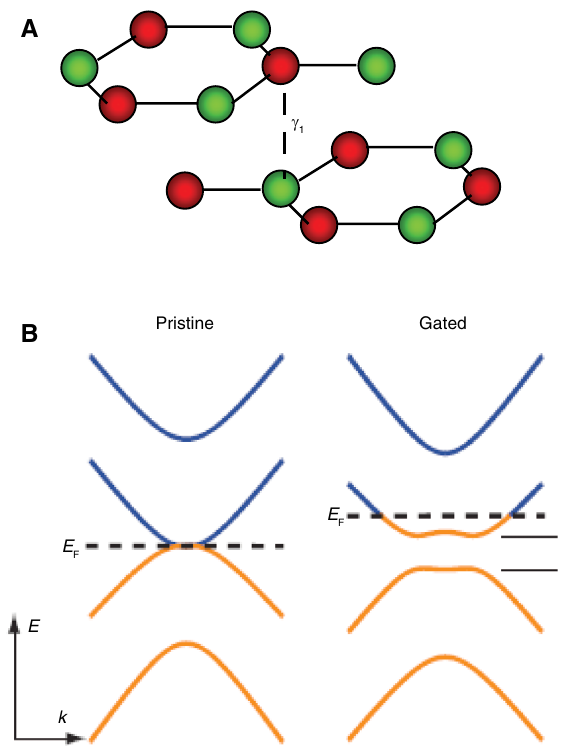
Figure 1 Bilayer graphene lattice and electronic band structure. (A) Lattice structure, γ is the interlayer coupling constant. (B) Illustra- 1 tion of the band structures for pristine and gated bilayer graphene. A band gap can exist for gated bilayer with an electrical field across the two layers (B reprinted with permission from [22], Copyright 2009 Nature Publishing